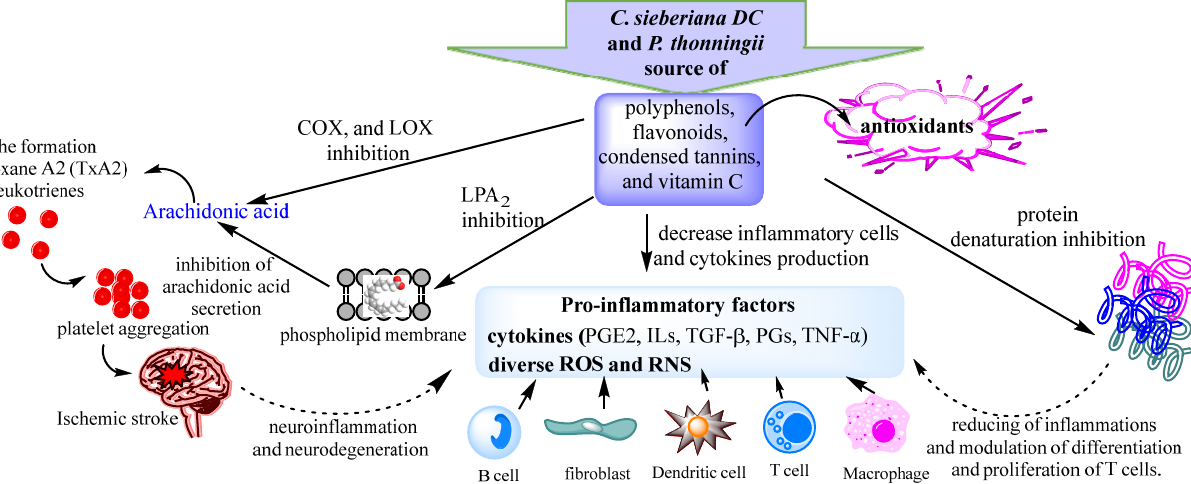
Figure 2. Proposed anti-inflammatory mechanisms of C. sieberiana and P. thonningii extracts .